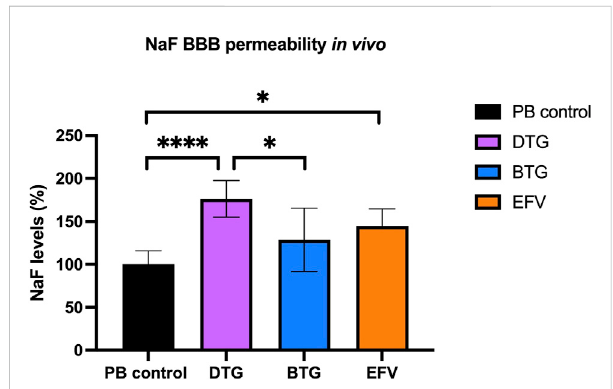
FIGURE 7 Quanti fi cationofNaFlevel inthemouse brain. Miceweretreated for 14 days with either vehicle (regular PB pellet), DTG (5 mg/kg/day), BTG (5 mg/kg/day) or EFV (10 mg/kg/day). Diffusion of sodium fl uorescein (NaF) from plasma into the brain parenchyma was usedastheindicatorofBBBpermeability.PB=peanutbutter.Dataare mean± SEM,expressedas fold change compared to vehicle, n = 5per group. One-way ANOVA with Bonferroni ’ s post-hoc test: *, p < 0.05; ****, p <